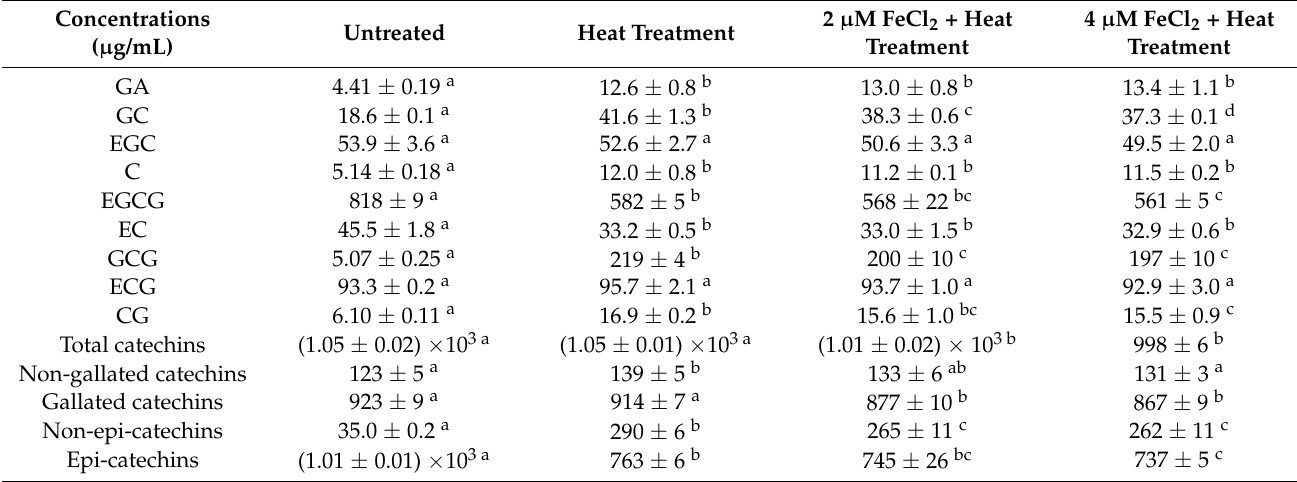
Table 2. Effect of Fe 2+ on the transformation of catechins in green tea infusion with heat treatment. Concentrations